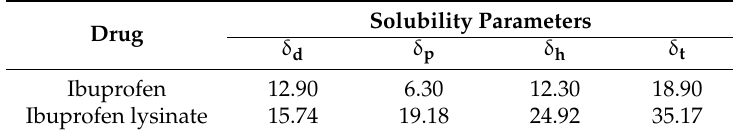
Table 5. Solubility parameters of ibuprofen, taken from [36], and ibuprofen lysinate obtained by using inverse gas chromatography.